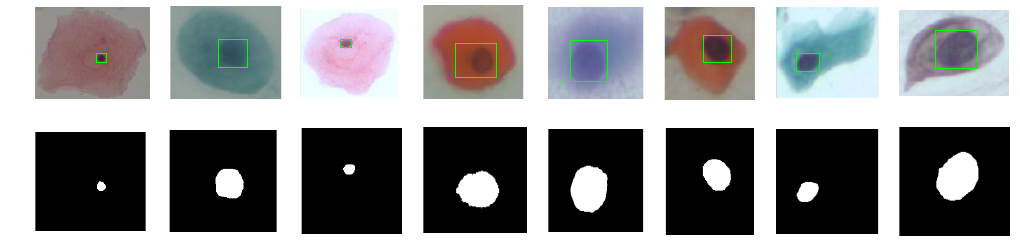
Figure 12. Nuclei detection from cropping single cells’ patches. Table 6. The performance of our proposed nuclei detection method.